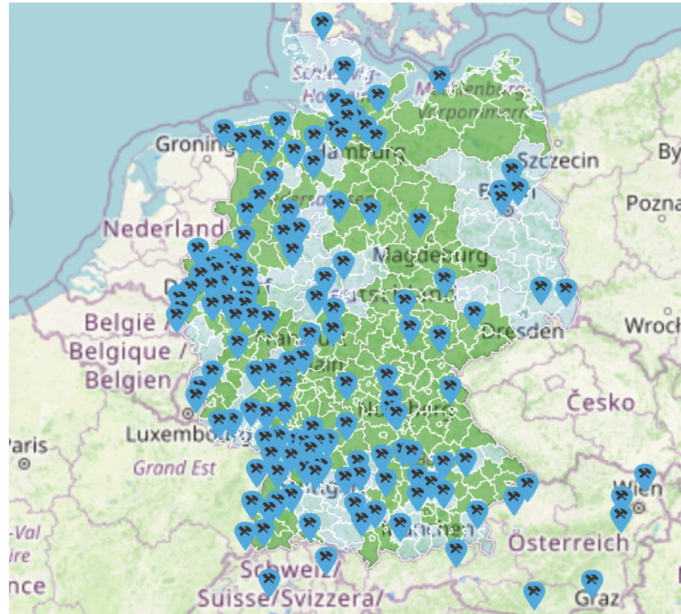
Figure 1. Network of hubs (blue symbols) connected via makervsvirus.org with those requiring personal protective equipment (PPE)